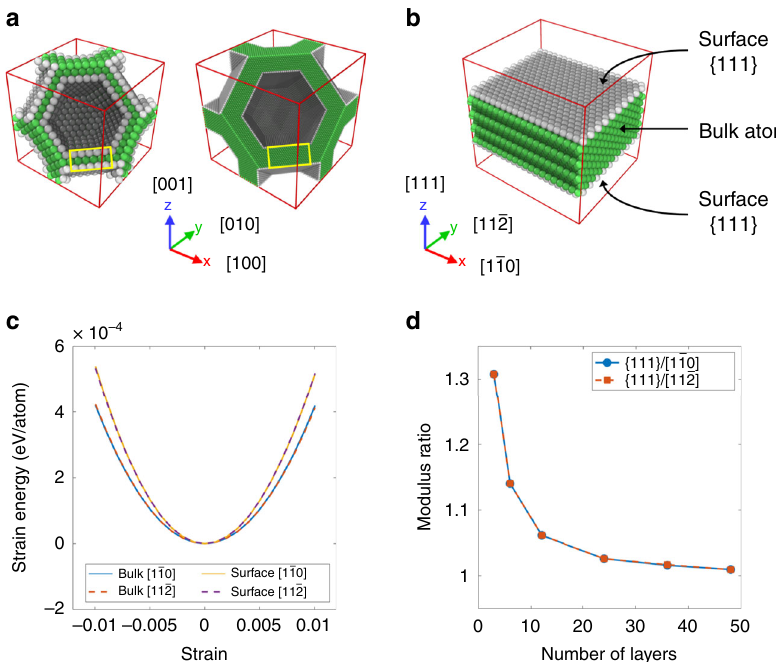
Fig. 4 Surface effect in nanostructured materials. a Slice views of the Nano-TO design with a volume fraction of 50% to reveal the interconnectivity. The bulk atoms are shown in green and the surface atoms are shown in gray. The length of the unit cell on the left is 4 nm and that on the right is 16 nm. The yellow boxes indicate a nanoplate structure with surfaces {111}. b The atomistic model of a nanoplate with surfaces {111}. c Strain – energy curves for the bulk model in the ½ 1 (cid:1) 10 (cid:2) (blue solid line) and ½ 11 (cid:1) 2 (cid:2) (red dashed line) directions, and for the surface model in the ½ 1 (cid:1) 10 (cid:2) (yellow solid line) and ½ 11 (cid:1) 2 (cid:2) (purple dashed line) directions. d The modulus ratios in the ½ 1 (cid:1) 10 (cid:2) (blue circles with solid line) and ½ 11 (cid:1) 2 (cid:2) (red squares with dashed line) directions for the nanoplates with varying numbers of layers. The modulus ratio is de fi ned as the modulus of a nanoplate divided by that of the bulk